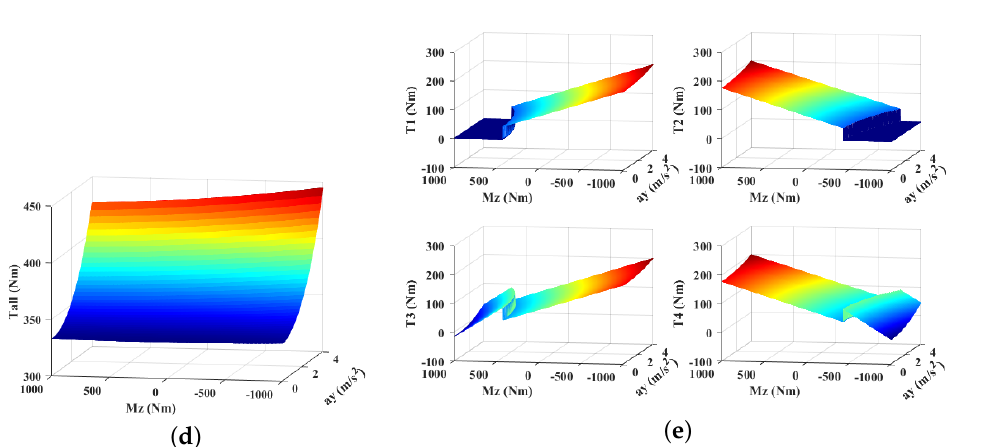
Figure 6. Results for acceleration during cornering with Motor I: ( a ) Minimal power; ( b ) Percentage of